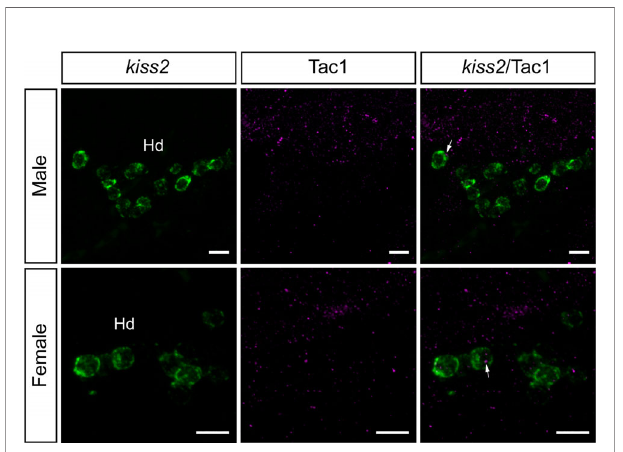
FIGURE 8 | Neuronal association between Tac1-immunoreactive processes and kiss2 cell soma in the male and female zebra fi sh. Photomicrographs for mRNA expression of kiss2 (1 st column), and Tac1-immunoreactivity (2 nd column) were merged (3 rd column) to elucidate the possible neuronal association between Tac1 and kiss2 neurons. Occasionally, some kiss2 mRNA containing cells ( green ) are accompanied by Tac1 processes ( magenta , arrows) in the dorsal zones of periventricular hypothalamus (Hd). However, they do not seem to form close associations based on the results of confocal scanning (data not shown). Scale bars: 10µm.